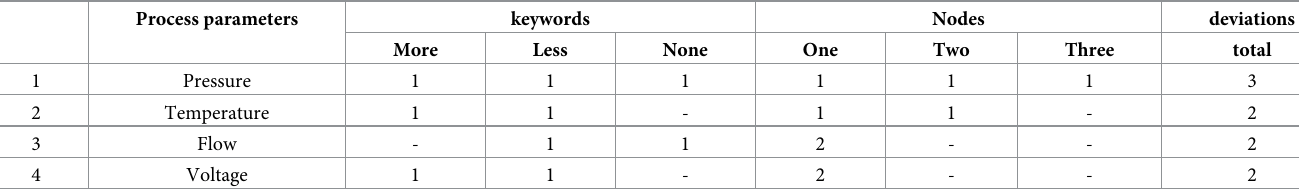
Table 4. The information about the deviations in the PSA system (Based on the causes). Process parameters